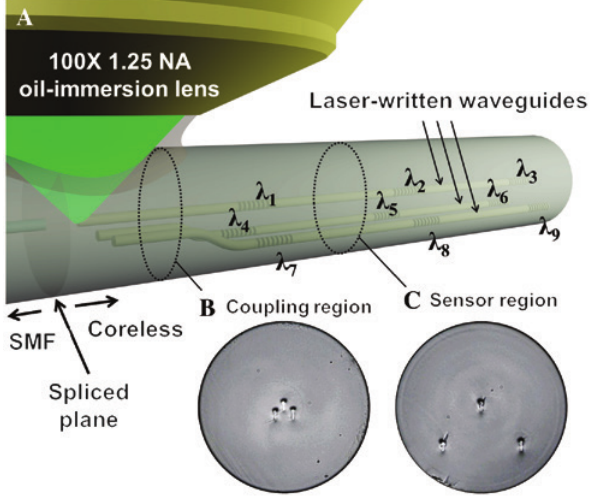
Figure 22: (A) Schematic of a 3D shape and thermal sensor written into coreless fused silica fibre by ULI. Microscope images of the fibre cross-section (125 m m diameter) at the (B) coupling and (C) sensor regions, showing the arrangement of the internal laser-writ- ten waveguides and WBGs. Reprinted with permission from [80].